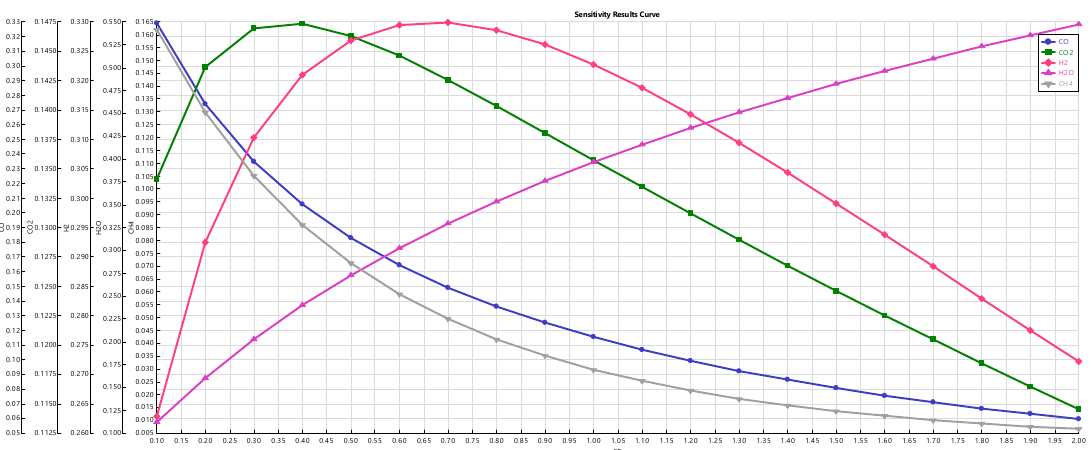
Figure 3. E ff ect of the S / B ratio on syngas composition. Figure 3. Effect of the S/B ratio on syngas composition. Figure 3. Effect of the S/B ratio on syngas composition.